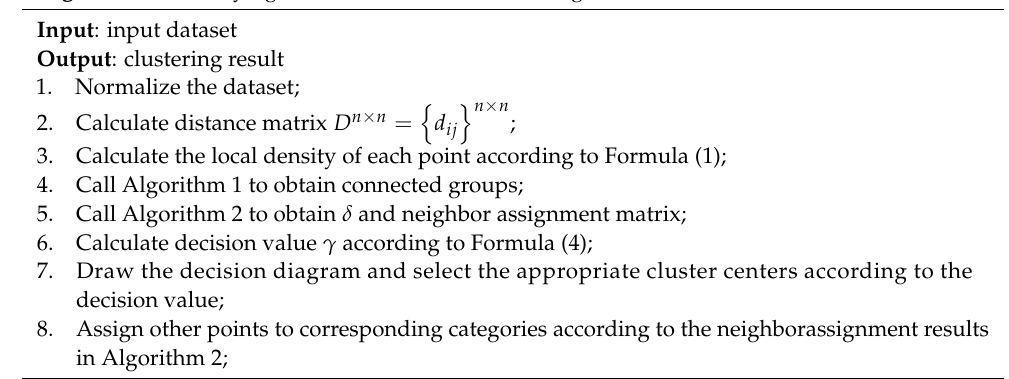
Algorithm 3 Identifying cluster centers and Label